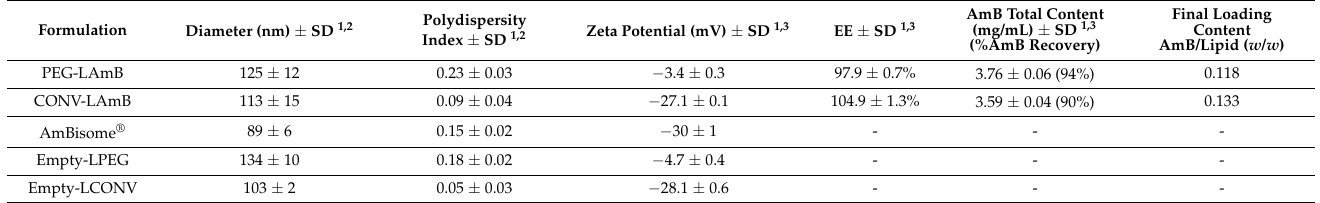
Table 1. Particle size distribution, zeta-potential, drug encapsulation efficiency (EE), and AmB total content of PEGylated (PEG-LAmB) and conventional (CONV-LAmB) liposomal AmB, in comparison to AmBisome ®